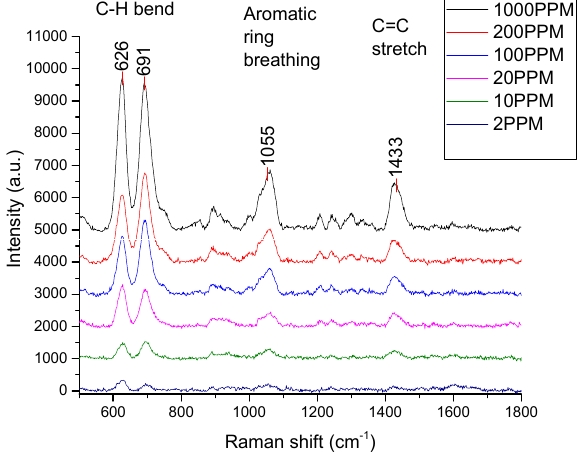
Figure 11. SERS spectra of different concentrations of DEHP (from 1000 ppm to 2 ppm) on the nanostructured SERS substrate. The Raman band assignment of the main peaks of DEHP is given in the figure.